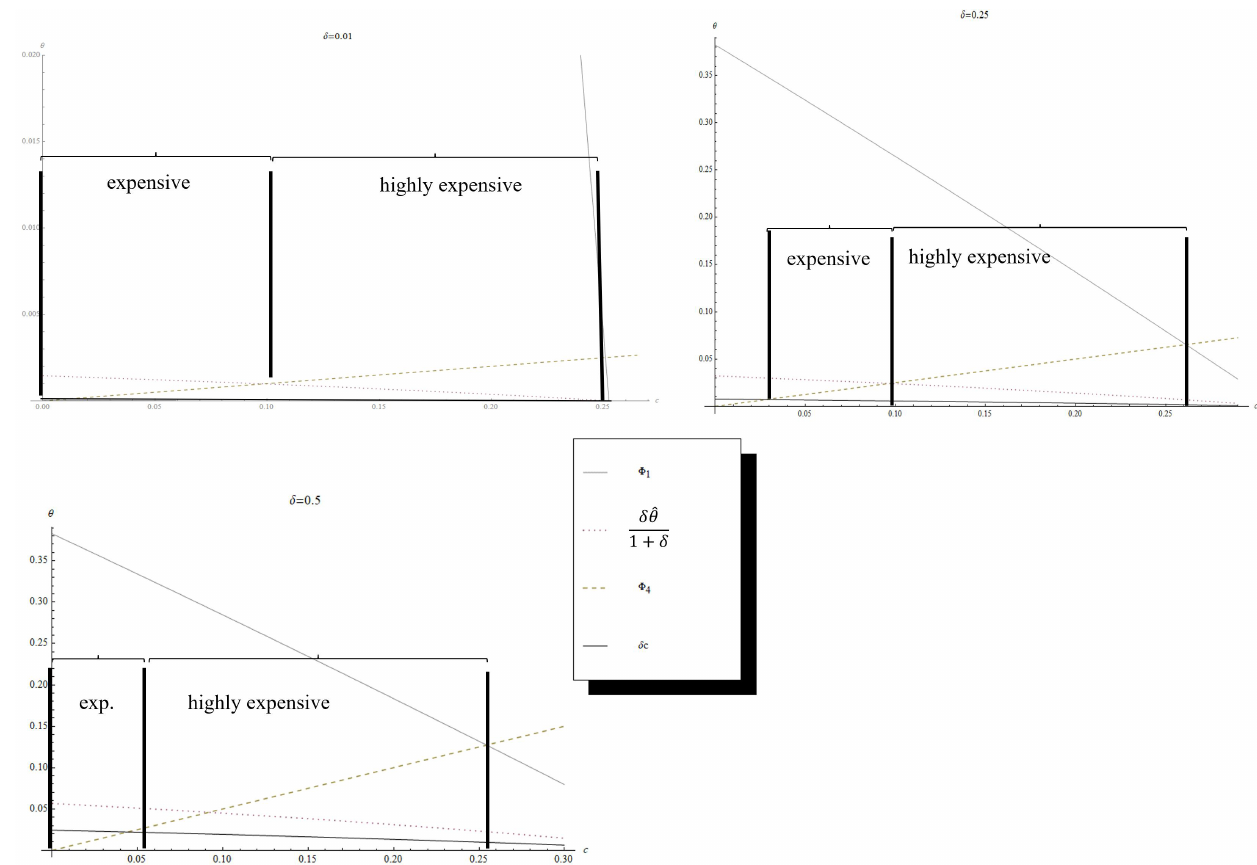
Figure 6. Existence of of expensive and highly expensive equilibria: δ = 0.01, δ = 0.25 and δ = 0.5.